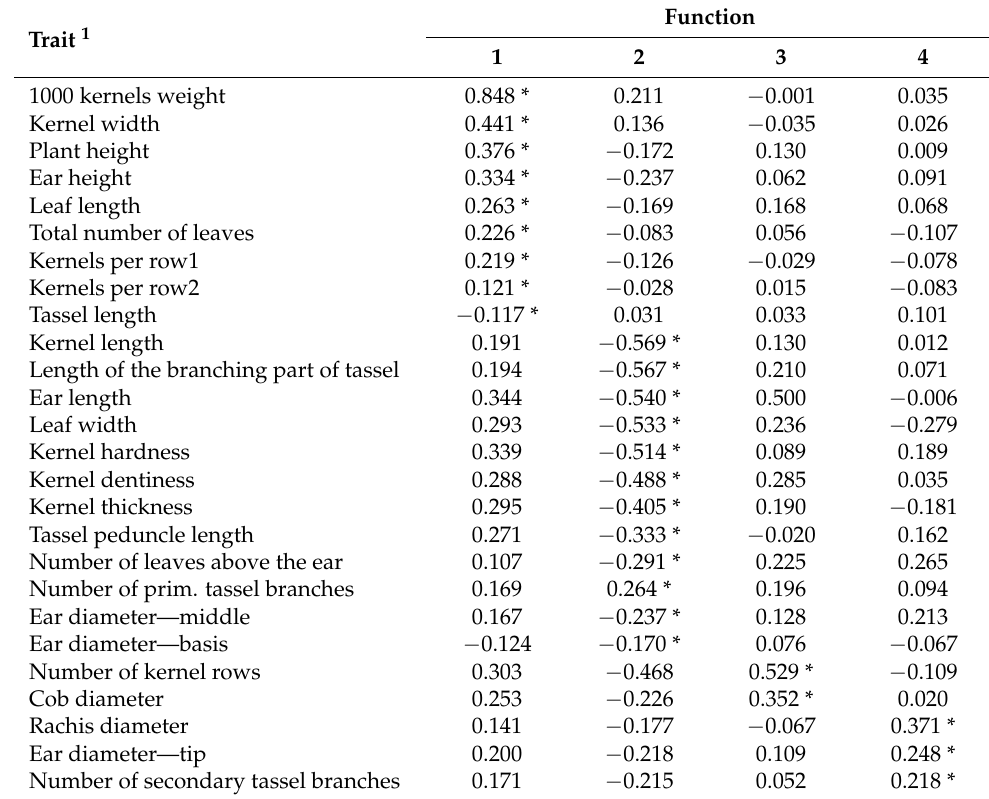
Table 7. Pooled within-group correlations between discriminant variables and standardised canonical discriminant